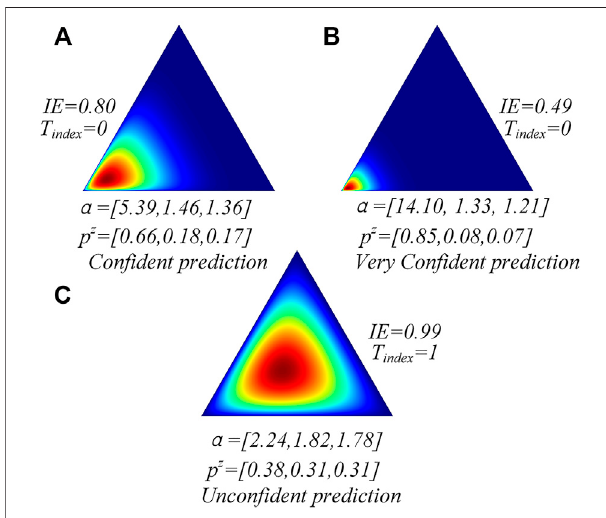
FIGURE1| PredictionoftheDirichletdistribution ofthethreeaminoacid samples ’ analysis.